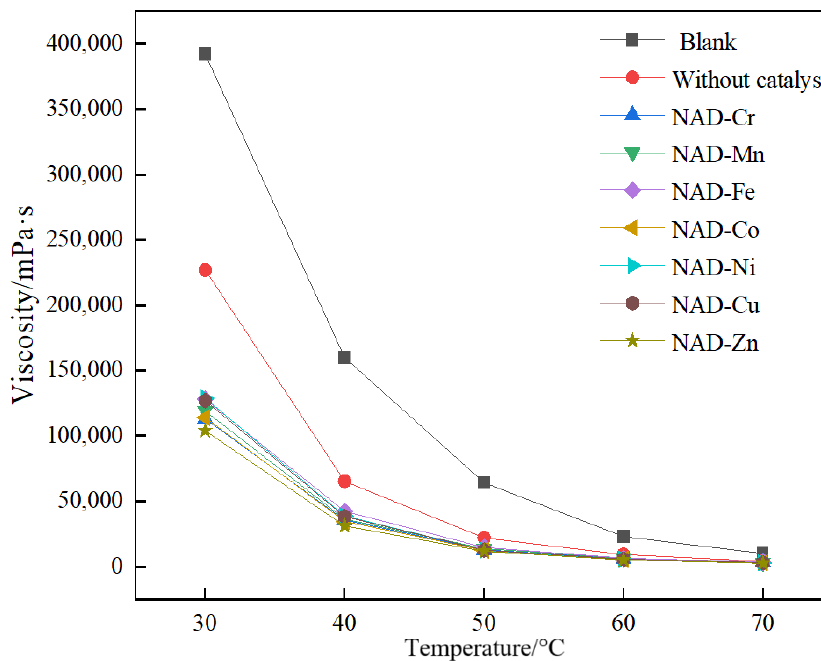
Figure 1. Effect of catalysts on the viscosity of catalytic aquathermolysis heavy oil.